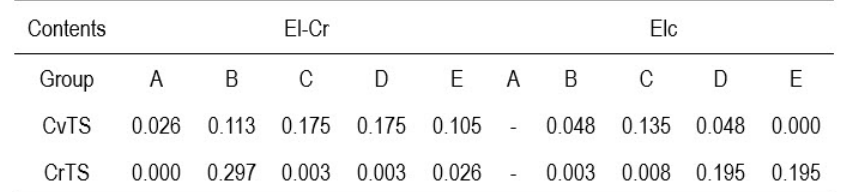
Levene’s Test of Equality of Error